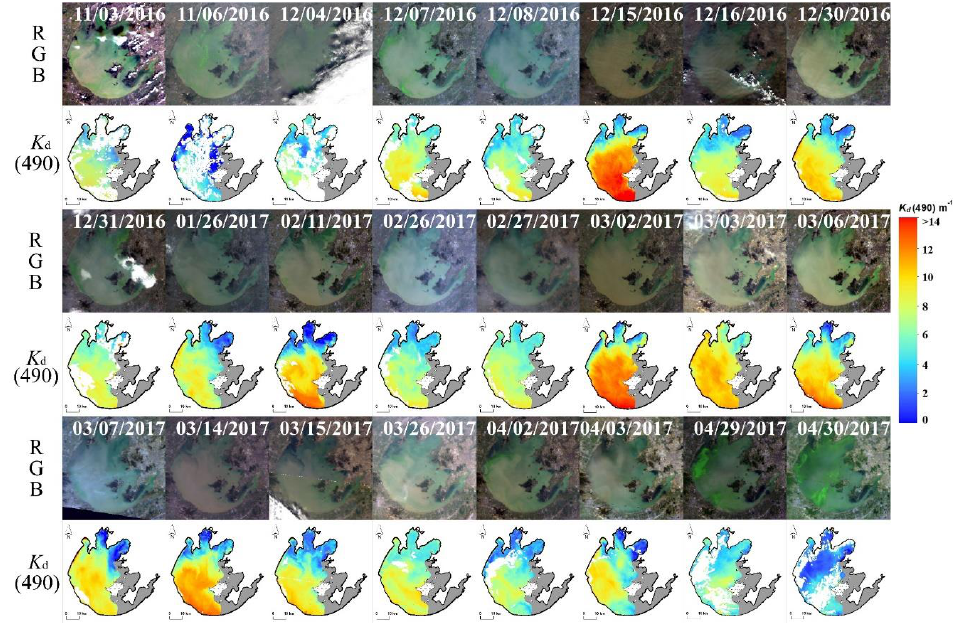
Figure 8. Daily OLCI RGB and K d (490) distributions in Lake Taihu, China, derived from Sentinel OLCI data (November 2016–April 2017). Note that the data influenced by algal blooms and clouds are excluded.